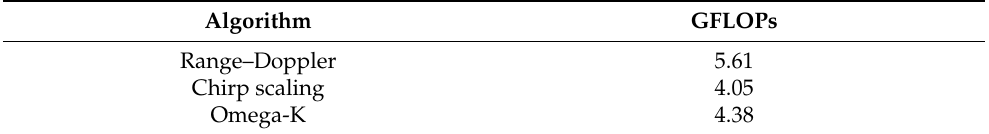
Table 4. Computational load of the Range–Doppler, chirp scaling and omega-K algorithms in GFLOP. These values were calculated and published in